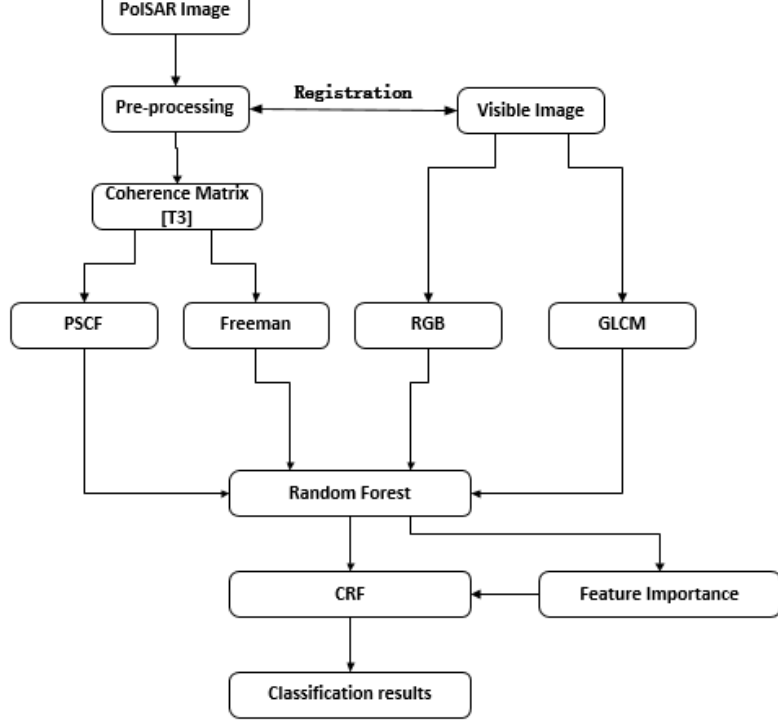
Figure 2. RF-Im_CRF model flowchart.